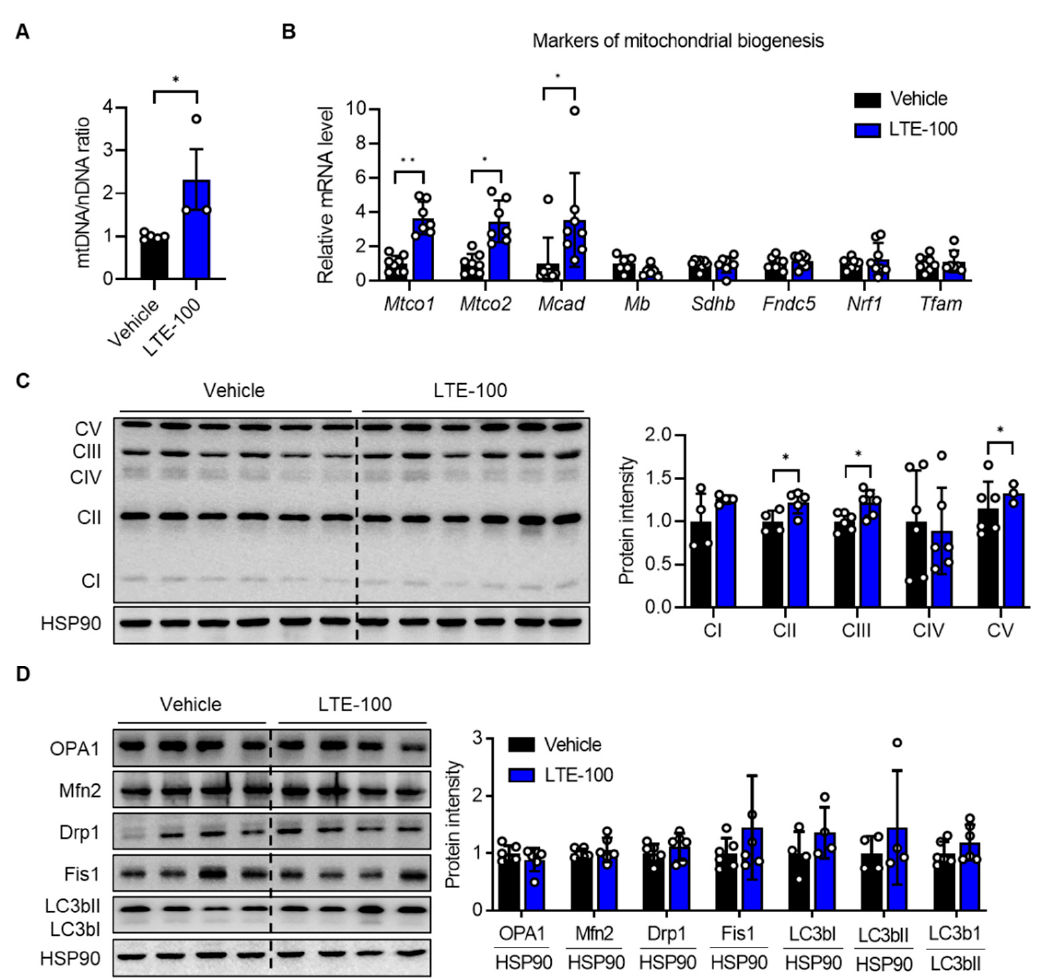
Figure 4. Effects of LTE supplementation on mitochondrial biogenesis . ( A ) Mitochondrial DNA (mtDNA) was quantified by qPCR using nuclear DNA (nDNA) as a standard ( n = 3–5). ( B ) qPCR analysis of genes related to mitochondrial biogenesis in GAS muscles ( n = 6–8). The expression of each gene was normalized with housekeeping gene Gapdh , whereas the expression of mitochondrial genome-encoded genes Mtco1 and Mtco2 was normalized with Ppia . ( C ) Western blotting analysis of the expression of OxPhos subunits and quantification of the intensity of OxPhos subunits relative to vehicle. ( D ) Western blotting analysis of mitochondrial fission and fusion genes. Western blot values are mean ± S.E.M ( n = 3–6). * p < 0.05 and ** p < 0.01. LTE-100, LTE 100 mg/kg